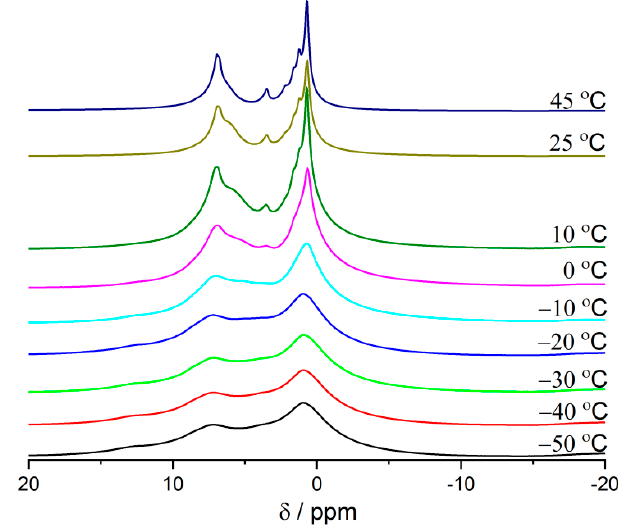
Figure 8. 1 H MAS NMR spectra of sample FAU31–24IBU recorded at different temperatures.